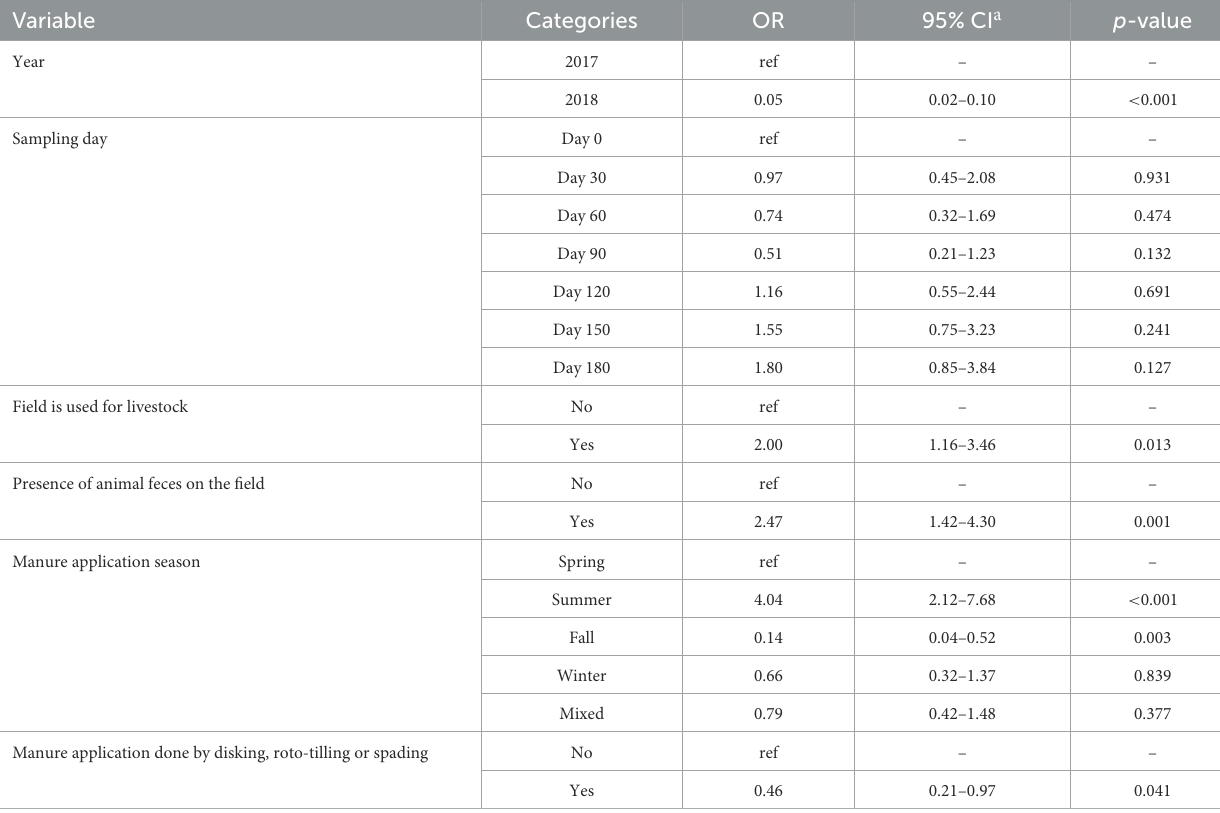
TABLE 4 Multivariable analysis, using a mixed-effect logistic regression model, of the sample-level, time-dependent and farm questionnaire factors (model 1) that influence the likelihood of non-O157 STEC presence in soil samples amended with untreated manure in certified organic farms. Variable